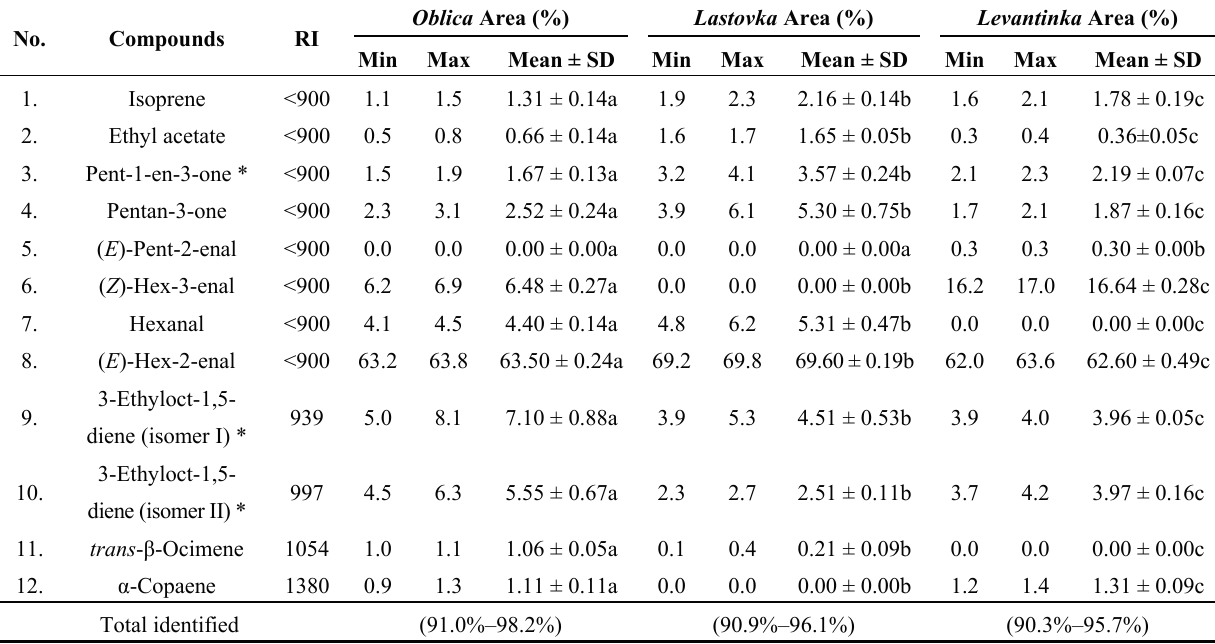
Table 2. The headspace volatiles from Oblica , Lastovka and Levantinka VOOs determined by